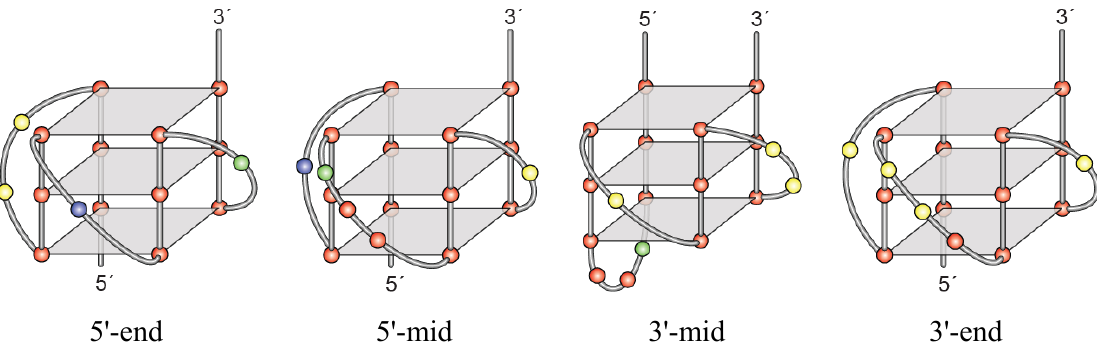
Figure 6. Models of the major G4 species from each truncated sequence (5'-end, 5'-mid, 3'-mid and 3'-end) were determined based on information from the CD and DMS footprinting data, including overall loop directionality (from CD) and majorly protected guanines (from DMS). Red = guanine, yellow = cytosine, blue = thymine, green = adenine.